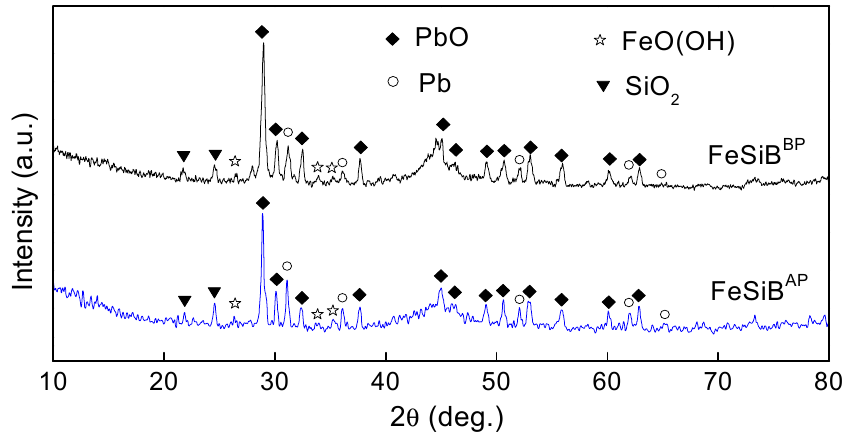
AP and FeSiB BP